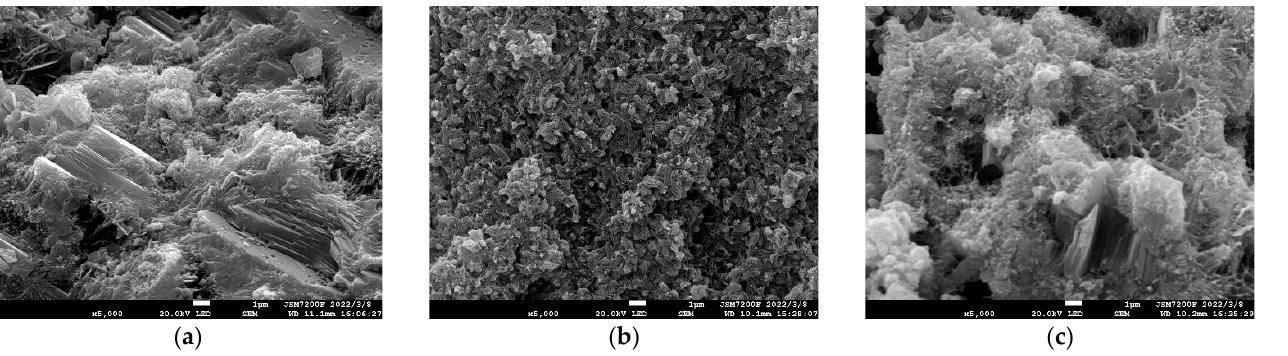
Figure 6. SEM micrographs of cement under different C/S and curing conditions. ( a ) 80 °C, 15 MPa; C/S = 1.8; ( b ) 150 °C, 15 MPa; C/S = 1.8; ( c ) 150 °C, 15 MPa; C/S = 1.1.